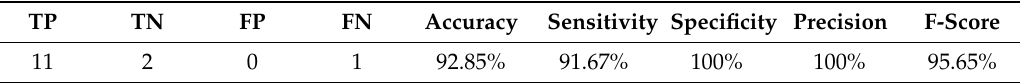
Table 7. Diagnostic accuracy of VH-IVUS to detect TCFA as determined by